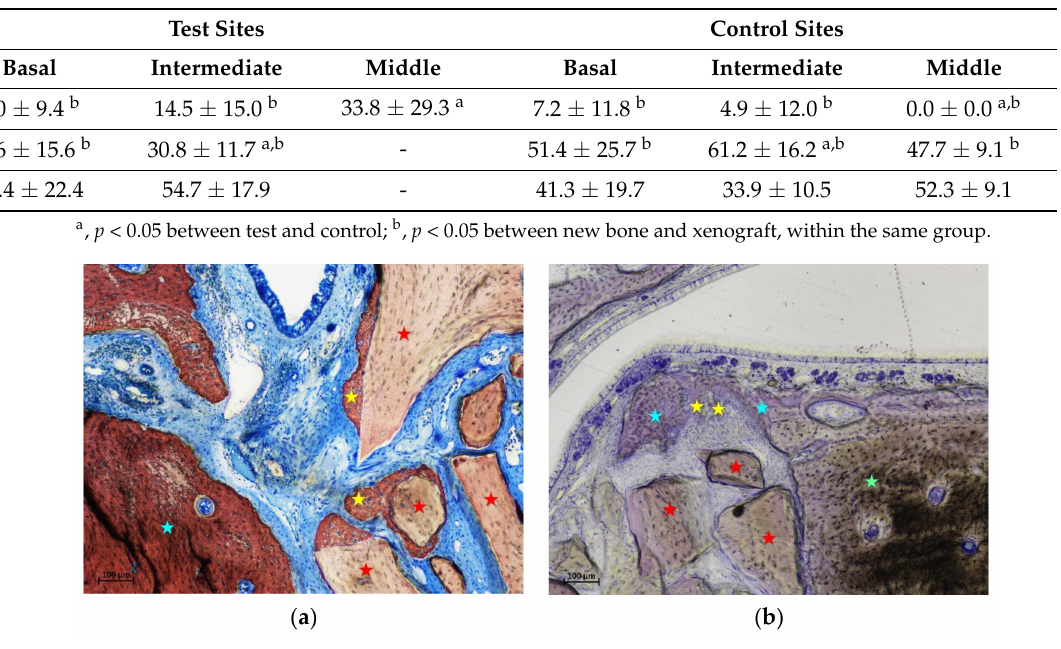
Table 2. Linear measurements. Tissues in contact with the sinus mucosa after 4 weeks of healing in the various regions evaluated. Mean values ± standard deviation in percentages. Test sites with the inward window.